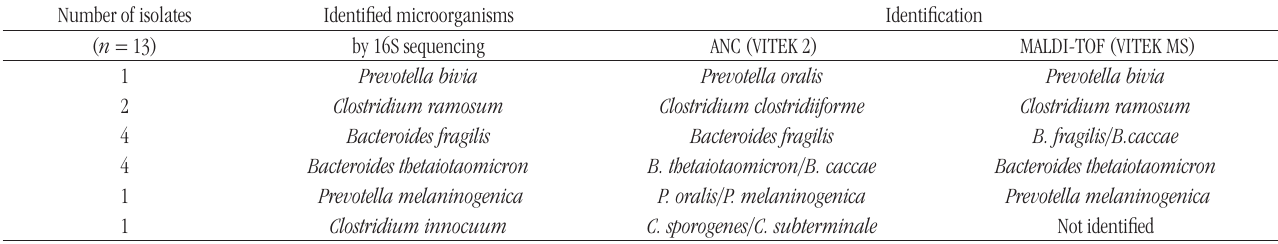
taBLE 3 − Conflicting results or with low differentiation of the species obtained by ANC (VITEK 2) and MALDI-TOF (VITEK MS), submitted to the 16S rRNA sequencing Number of isolates Identified microorganisms Identification